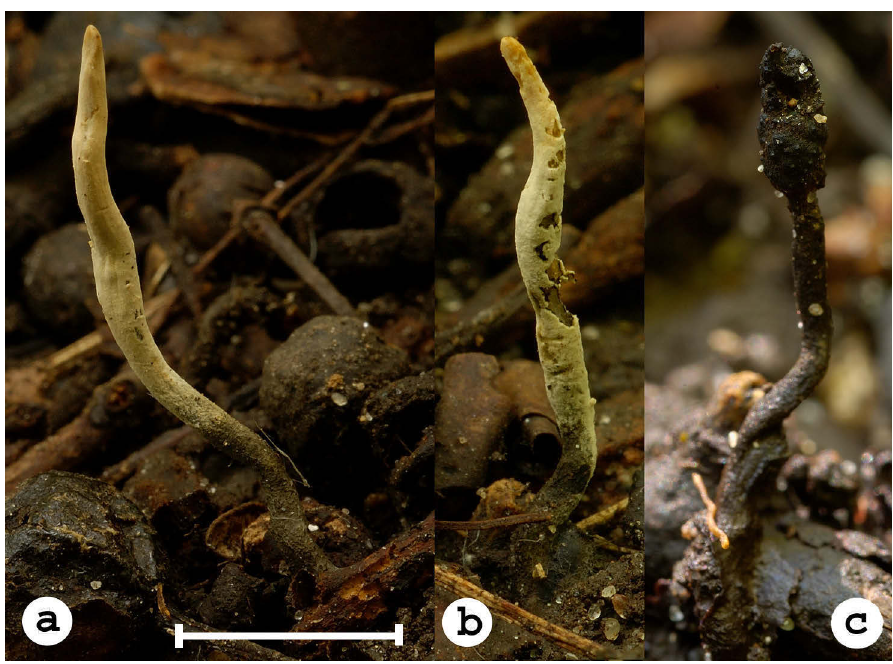
Fig. 2. Xylaria oxyacanthae – locality in Kraków: a) anamorphic stage; b) anamorfa damaged by Armadilidium vulgare ; c) teleomorphic stage. Phot. D.